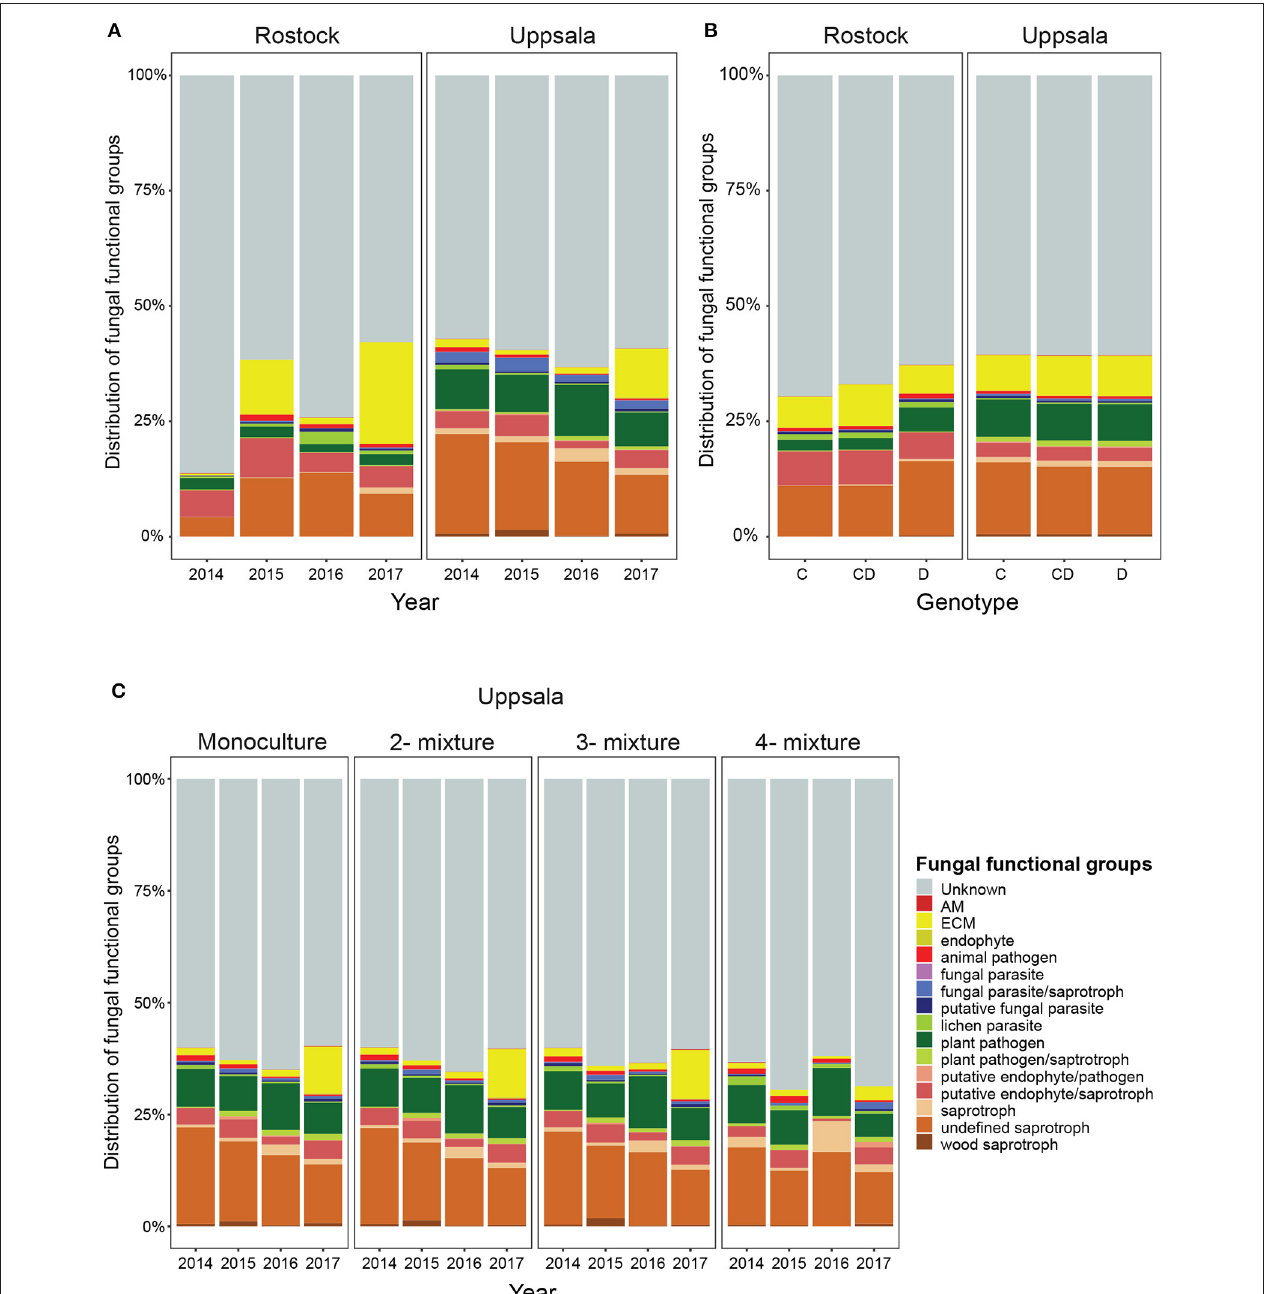
FIGURE 3 | Distribution of fungal functional groups in soil from Salix genotype trials in Rostock, Germany, and Uppsala, Sweden: (A) over time (preplanting in 2014 to 2017) (B) in monocultures of “Loden” or “Tora” and in 2-mixtures of “Loden” and “Tora”, and (C) for Uppsala only, in monoculture, 2-, 3-, and 4-mixtures, as estimated by PacBio sequencing of amplified ITS2 markers. Abundances are given as percent of the identified amplicon sequences, based on rarefied data (accounting for 80% of total sequences). There was a large increase in the proportion of ECM fungi three years after planting at both sites, especially in monoculture, 2- and 3-mixtures in Uppsala but with a smaller increase in